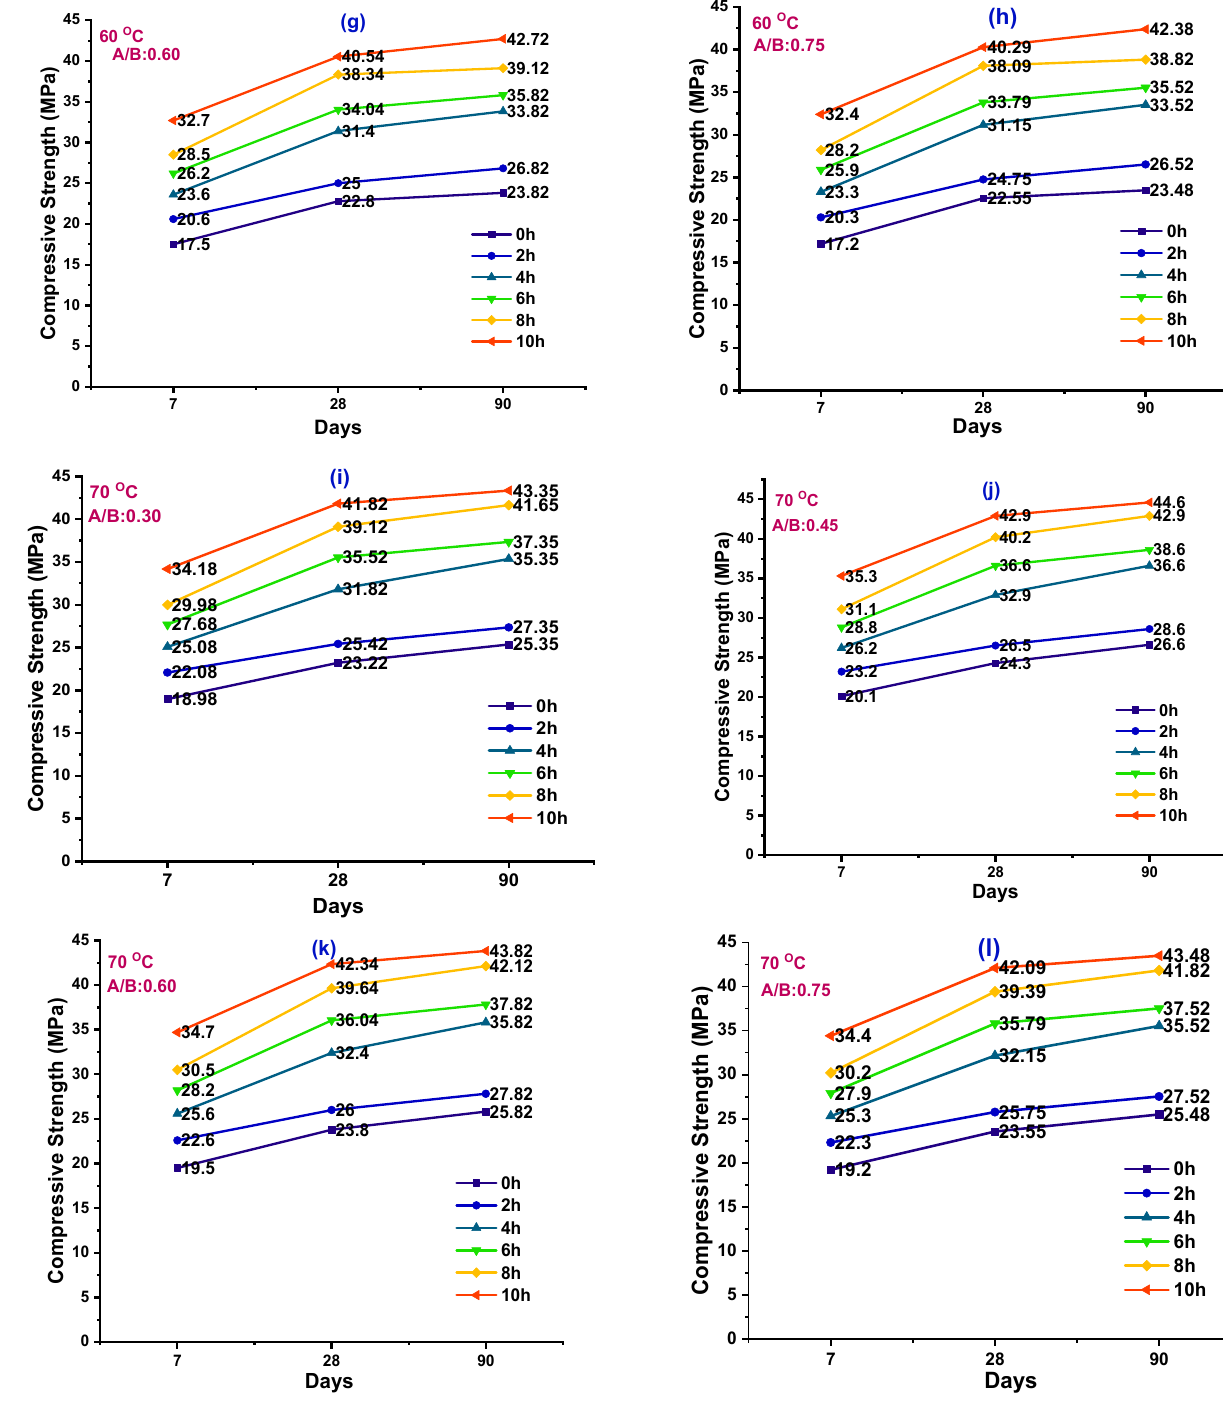
Figure 1. CS results of DT analysis tested at 7, 28, and 90 days. GPC specimens were cured at different temperatures: ( a – d ) cured at 50 ℃ , ( e – h ) cured at 60 ℃ , ( i – l ) cured at 70 ℃ .